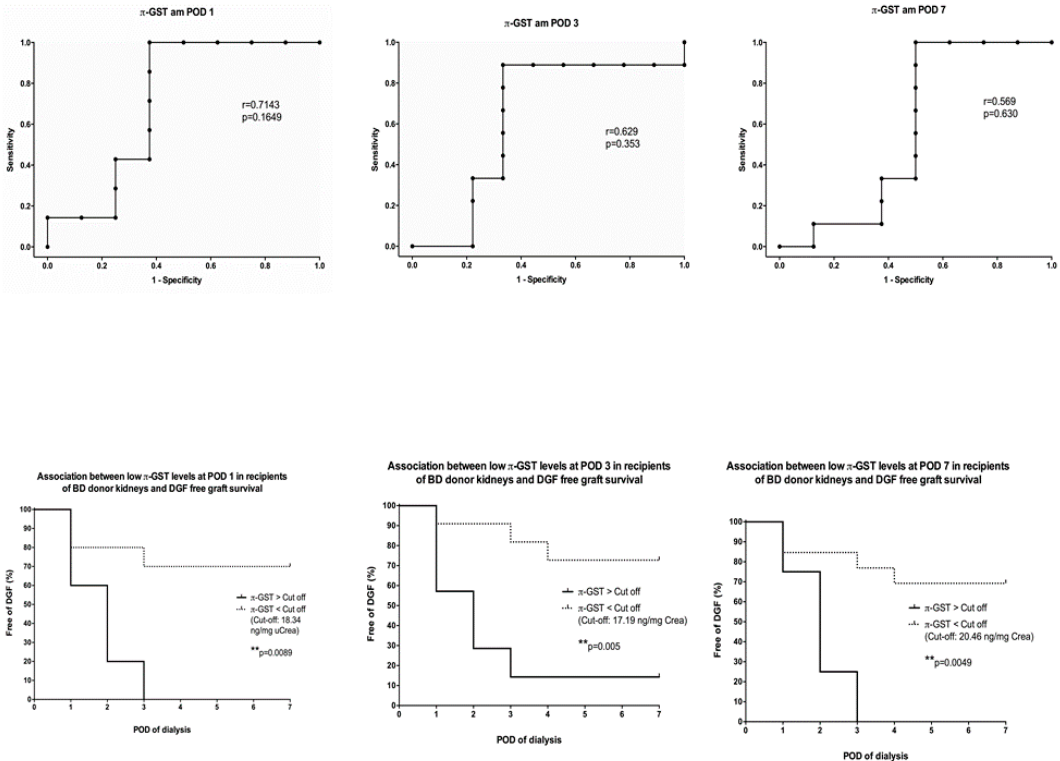
Figure 5. Correlation between urinary π -GST levels in recipients of brain-dead donors’ grafts on POD 1, 3, and 7; and probability of graft survival without delayed graft function (DGF) during the first week after transplantation.